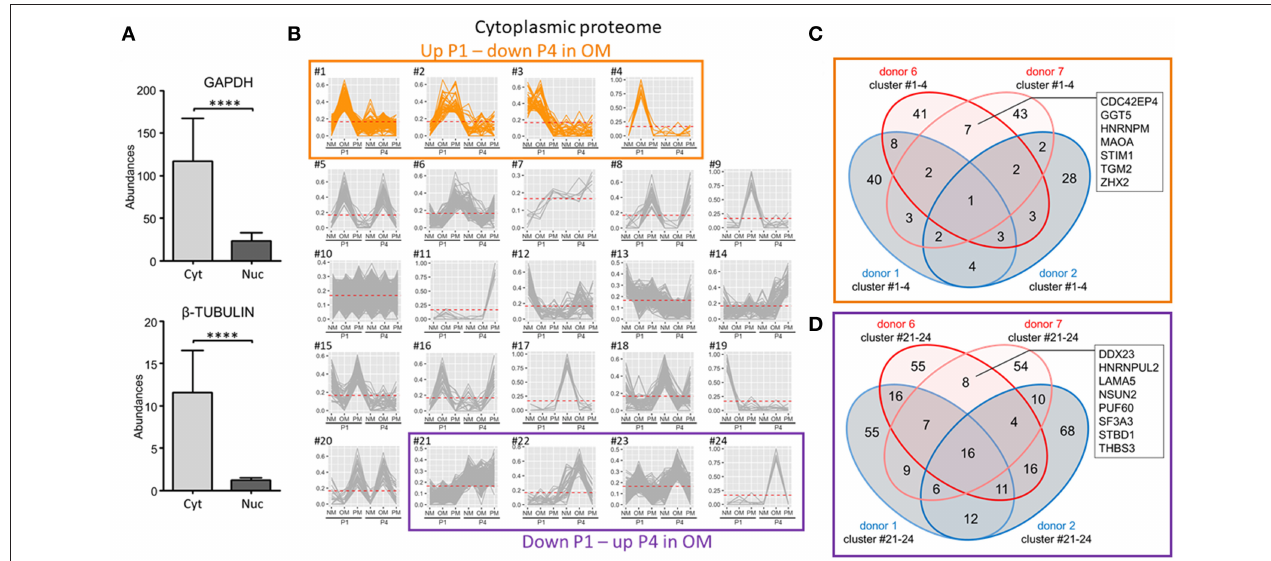
FIGURE 6 | Cytoplasmic-enriched fraction proteomics identified novel proteins associated with VIC calcification in OM. (A) Confirmation of cytoplasmic enrichment using two cytoplasm markers, glyceraldehyde 3-phosphate (GAPDH) and tubulin- β ; n = 4 donors/fraction, **** P < 0.0001 analyzed by t -test, error bars indicate SD. (B) XINA clustering analysis of protein abundances in NM, OM, and PM. Clusters with increased protein abundance at passage one (P1) and decreased abundance at passage four (P4) in OM indicated (clusters #1–4). Clusters with decreased protein abundance at P1 and increased abundance at P4 in OM indicated by purple box (clusters #21–24); n = 4 donors. (C) Venn diagram showing total number of proteins detected for the four donors analyzed (donors 1, 2, 6, 7) and found in the four identified clusters in which abundance was increased at P1 and decreased at P4 in OM. Calcification-prone donors (calcified at P1 in OM; donors 6 and 7) indicated by red color, and calcification-resistant donors (did not calcify at P1 in OM; donors 1 and 2) indicated by blue color. Proteins detected in the four clusters of the two calcification-prone but not in the calcification-resistant donors indicated: CDC42 effector protein 4 (CDC42EP4), gamma-glutamyltransferase 5 (GGT5), heterogeneous nuclear ribonucleoprotein M (HNRNPM), monoamine oxidase A (MAOA), stromal interaction molecule 1 (STIM1), transglutaminase 2 (TGM2), and zinc fingers and homeoboxes 2 (ZHX2). (D) Venn diagram showing total number of proteins detected for the four donors analyzed (donors 1, 2, 6, 7) and found in the four identified clusters in which abundance was decreased at P1 and increased at P4 in